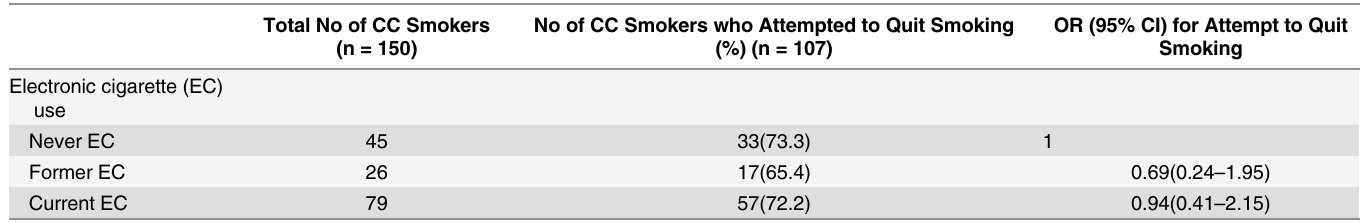
Table 4. Results of logistic regression analyses for assessing the association of EC and an attempt to quit smoking in the subset of asthmatics. Total No of CC Smokers (n = 150)